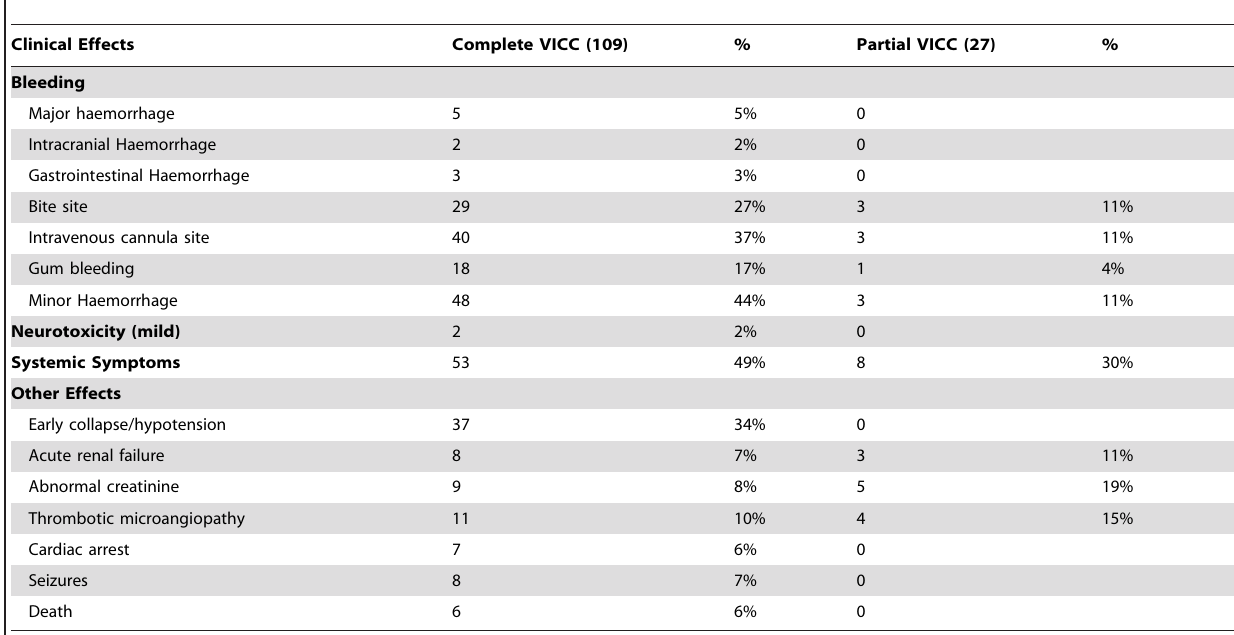
Table 4. Comparison of the clinical effects between patients with complete VICC and partial